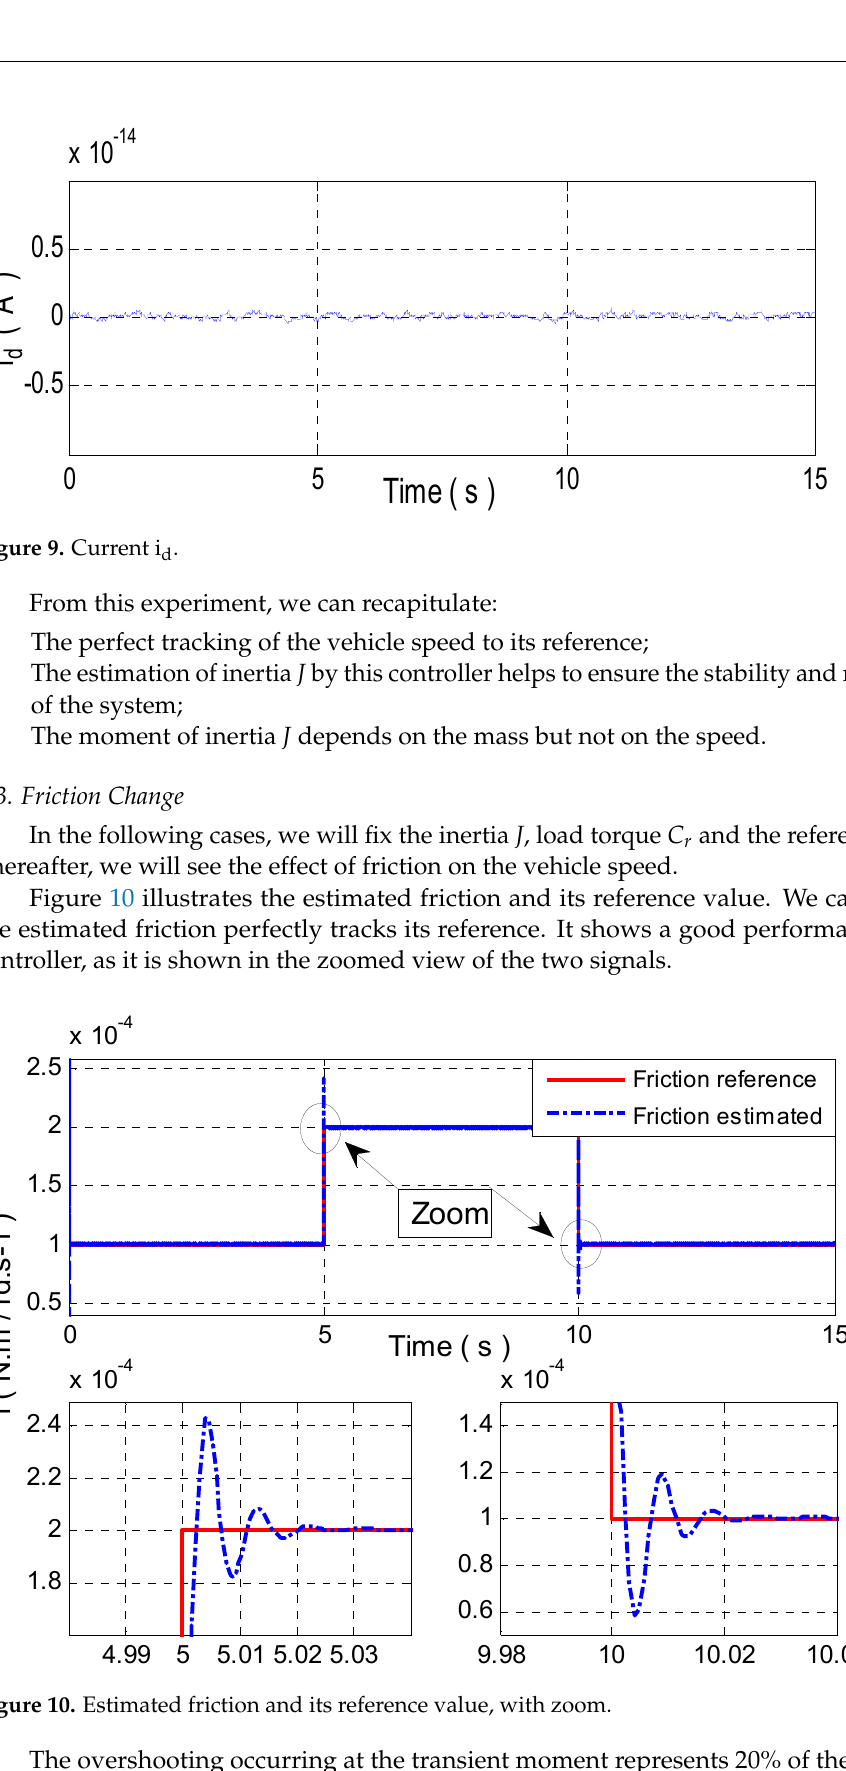
Figure 8. Current i q , with zoom.